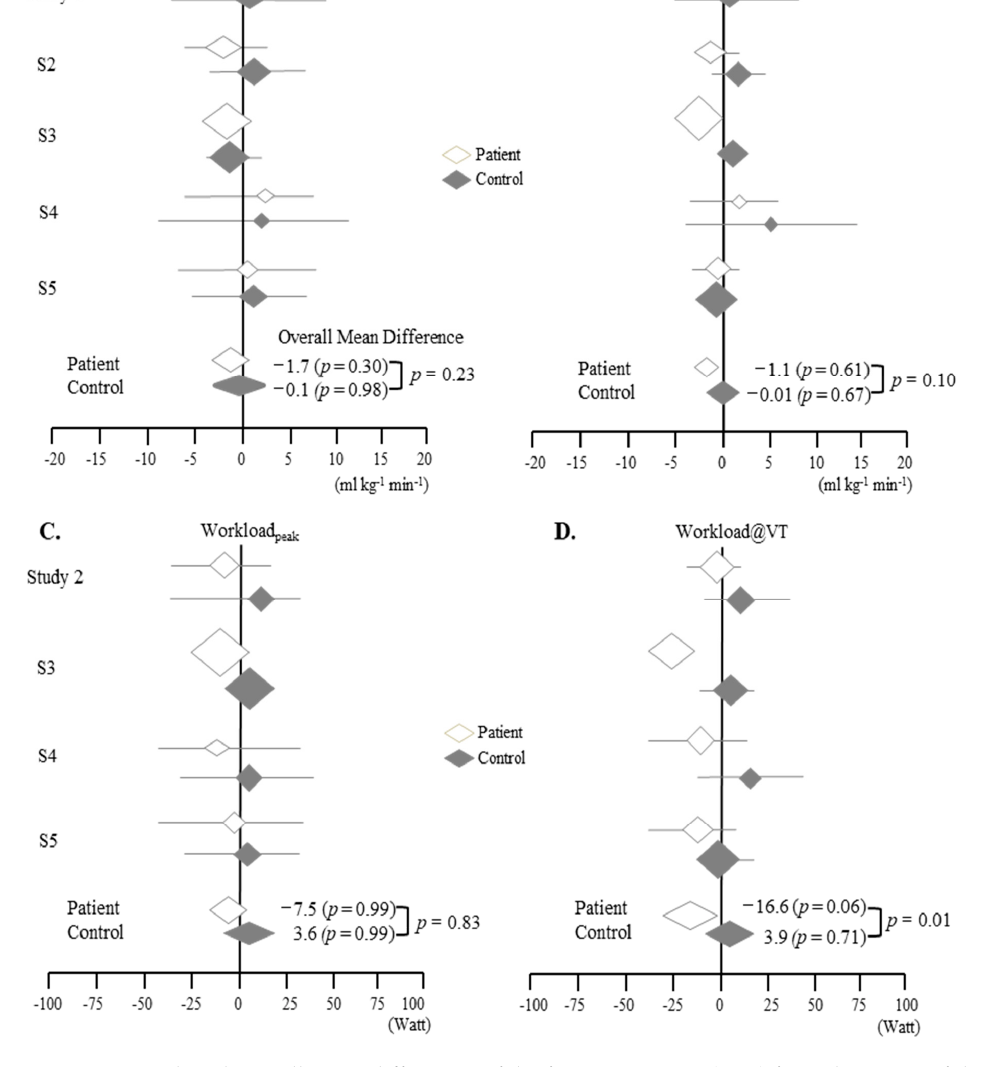
Figure 2. Meta analyzed overall mean differences of the four parameters (A-D) from the scores of the two-day CPET (test 2–test 1) for the ME/CFS (Myalgic encephalomyelitis/chronic fatigue syndrome) patients and controls: ( A ). VO 2 peak, ( B ). VO 2 @VT, ( C ). Workloadpeak, ( D ). Workload@VT. p , p value. Refer to Table 3 for details.